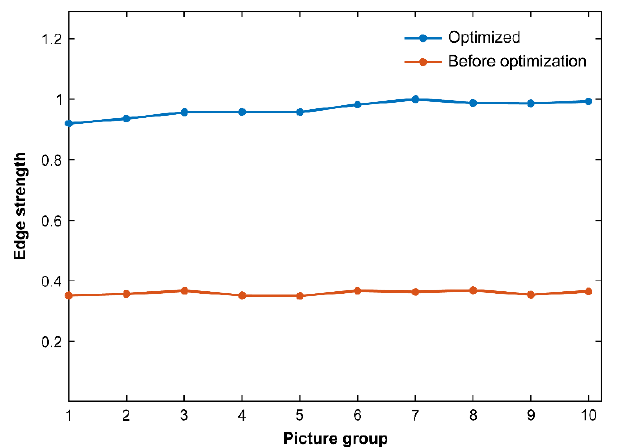
Figure 18. Edge strength obtained from the analyzed images before and after optimization.